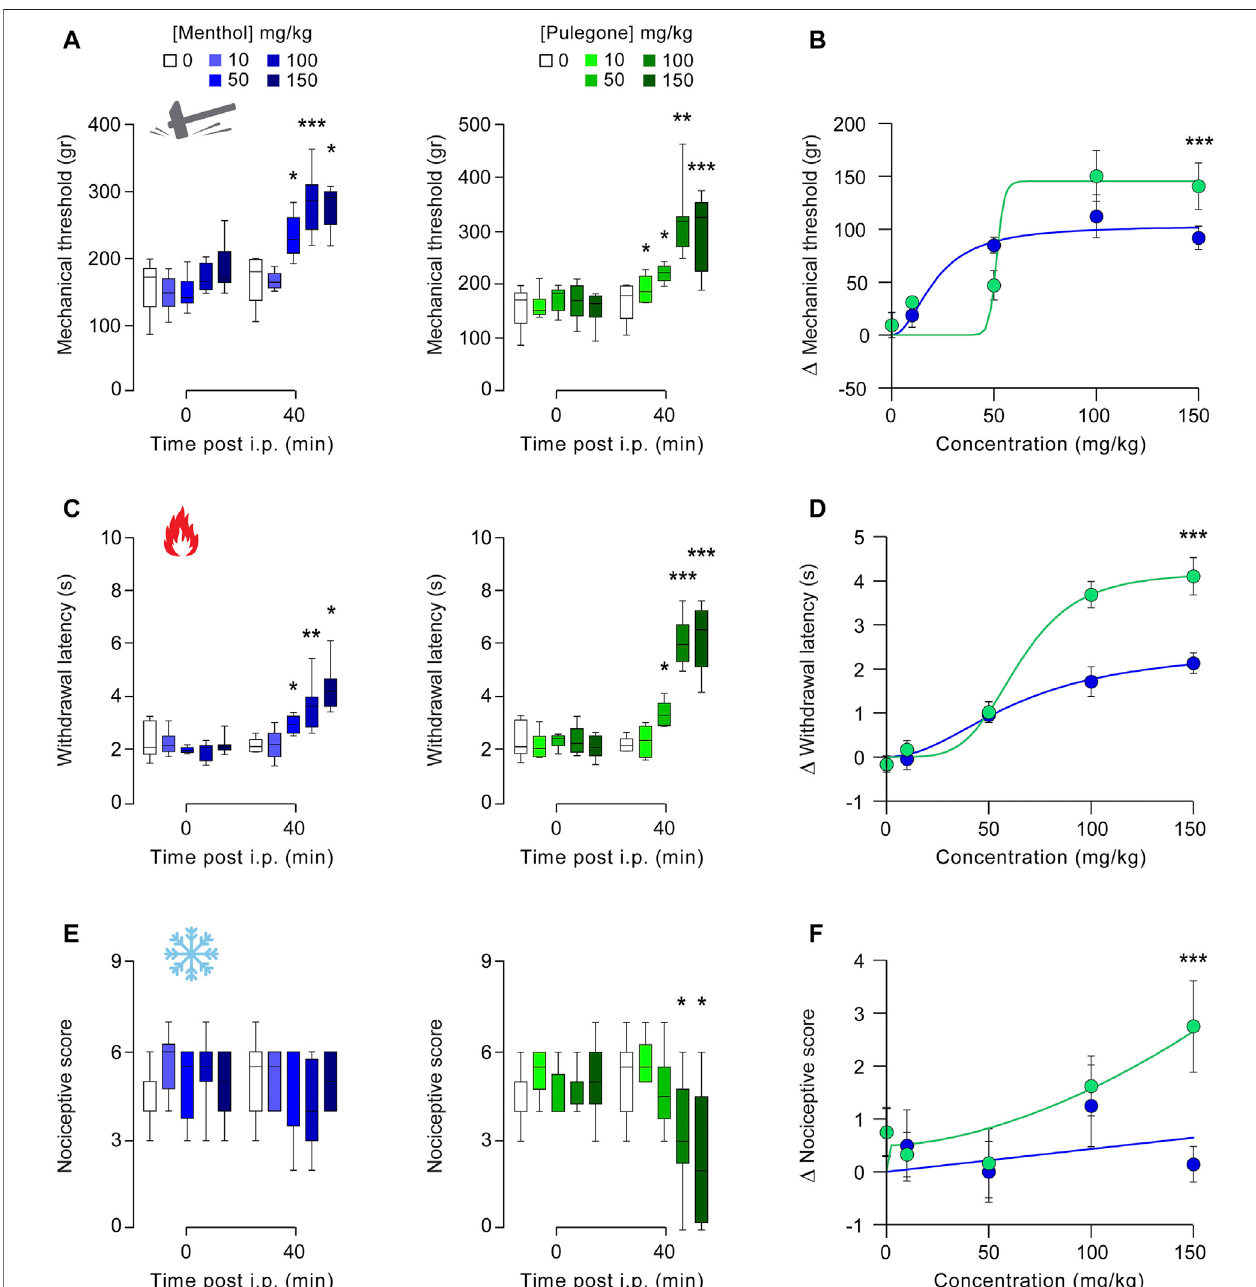
FIGURE3| Dose-response oftheanalgesic properties ofmentholand pulegone onCFA-inducedin fl ammatorypain model. Effect ofmenthol 10( n (cid:1) 6), 50( n (cid:1) 6), 100 ( n (cid:1) 8), and 150 mg/kg ( n (cid:1) 7) and pulegone 10 ( n (cid:1) 6), 50 ( n (cid:1) 6), 100 ( n (cid:1) 8), and 150 mg/kg ( n (cid:1) 8) or their vehicle ( n (cid:1) 8) measured 40 min after i.p. injection on mechanical (A) ,thermal heat (C) ,and thermalcold. (E) CFA-inducedhyperalgesia.Dose-response distribution fi tsformentholand pulegone onmechanical (B) ,thermal heat (D) ,and thermalcold (F) .Dataareexpressed asmean ± SD.Asterisksindicatestatisticalsigni fi cance (*** p < 0.001;** p < 0.01; * p < 0.05) usingKruskal-Wallis test followed by Dunn ’ s multiple comparisons post-hoc test to compare each delta with the delta of the vehicle, to compare each treatment depending on the time post i.p. (0 vs. 40 min) it is a paired t -test or a Wilcoxon test, depending on the data ’ s normal distribution.